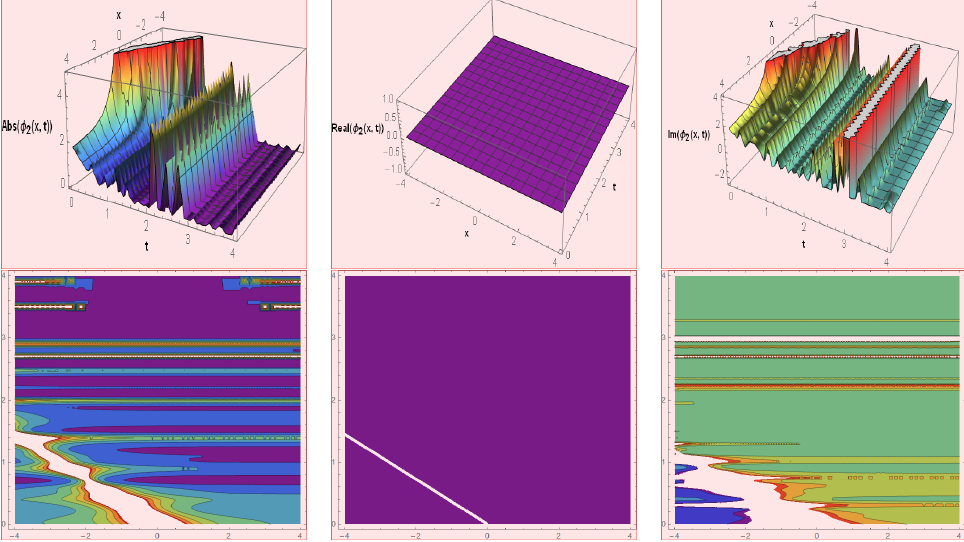
Figure 2. The absolute, real, and imaginary behavior in the shape of 3D and their corresponding contour plots are dispatched for φ 2 ( x , t )